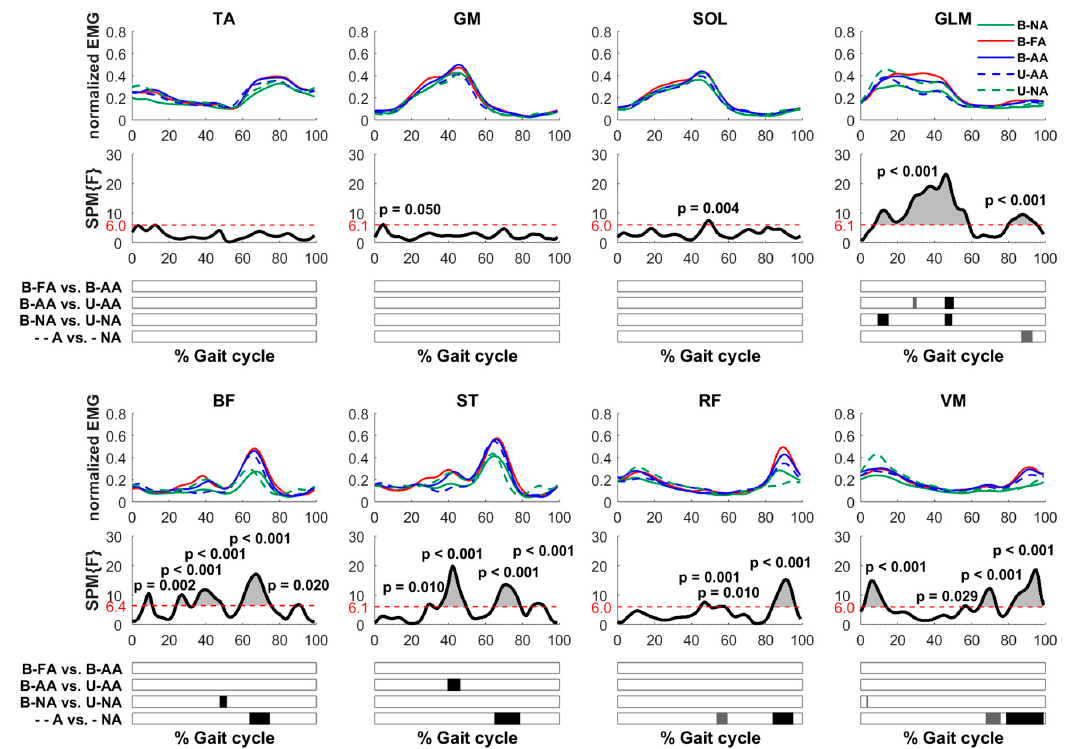
Figure 5. First and fourth rows: Muscle activations patterns during walking inside the Ekso with different assistance modalities. Unilateral assistance was indicated with dashed lines, while bilateral assistance was indicated with continuous lines, and the type of assistance was indicated by the color of the lines: B-FA (red), B-AA, U-AA (blue), B-NA, and U-NA (green). We considered the following muscles: muscles tibialis anterior (TA), gastrocnemius medialis (GM), soleus (SOL), rectus femoris (RF), vastus medialis (VM), semitendinosus (ST), biceps femoris (BF), and gluteus medius (GLM). Second and fifth rows: SPM{F} statistic as a function of the percentage of gait cycle. The lines were obtained by averaging the strides performed with crutches and walkers as well as the strides started with the left and right leg. The threshold for significance is indicated in red. Third and sixth rows: Statistic results of the pre-planned comparison: (1) B-FA vs. B-AA, (2) B-AA vs. U-AA, (3) B-NA vs. U-NA, (4) –A vs. -NA. Black intervals p < 0.001 and grey intervals p < 0.05.